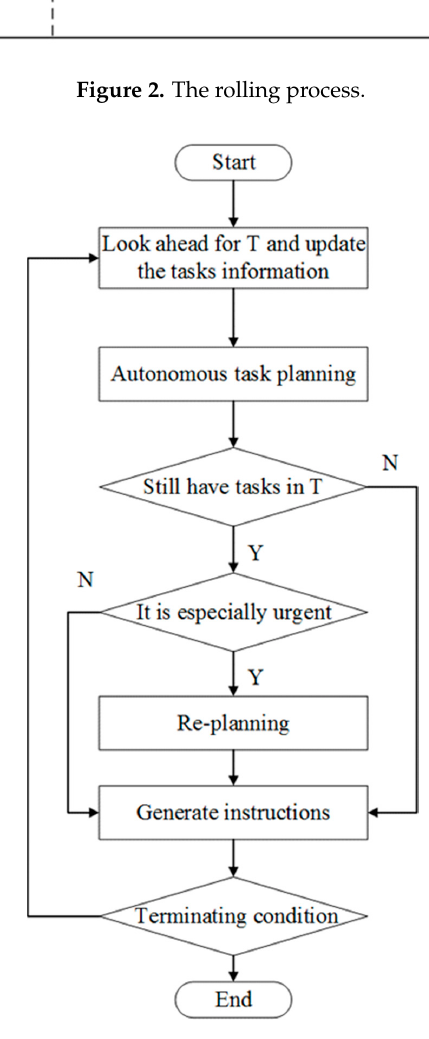
Figure 3. The process of autonomous task planning.